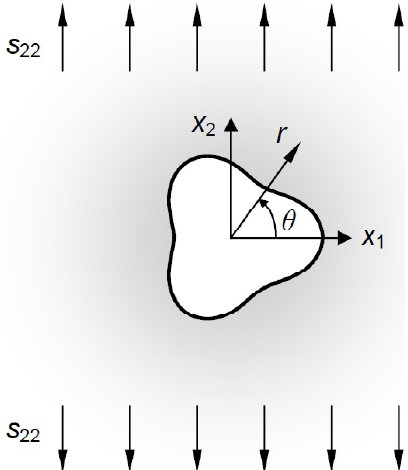
Fig. 3. Loading scheme for an elastic medium con- taining a cylindrical pore of three-fold symmetry under uniaxial tension s . 22